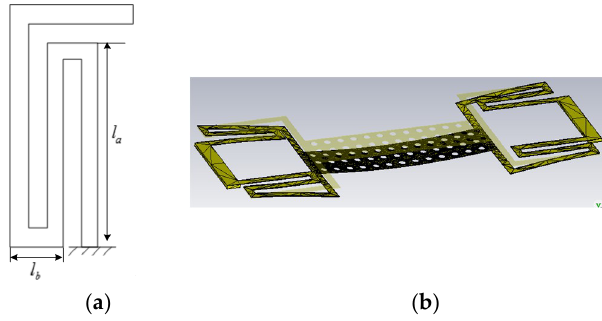
Figure 8. The structure of the MEMS beam. ( a ) A quarter of the beam; ( b ) Computer simulation technology (CST) simulation of the force of the switch beam.